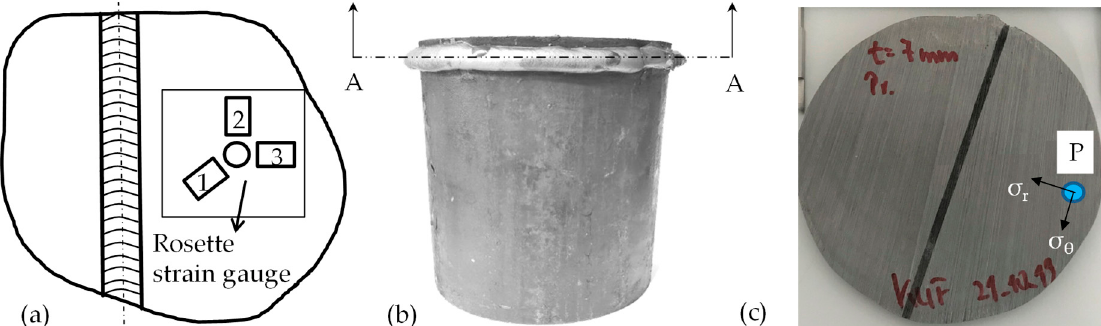
Figure 13. Schematic representation of the hole drilling method ( a ), cut section (A-A) of the tool to measure the residual stresses ( b ), and the location of the drilled hole P on the cut section ( c ).